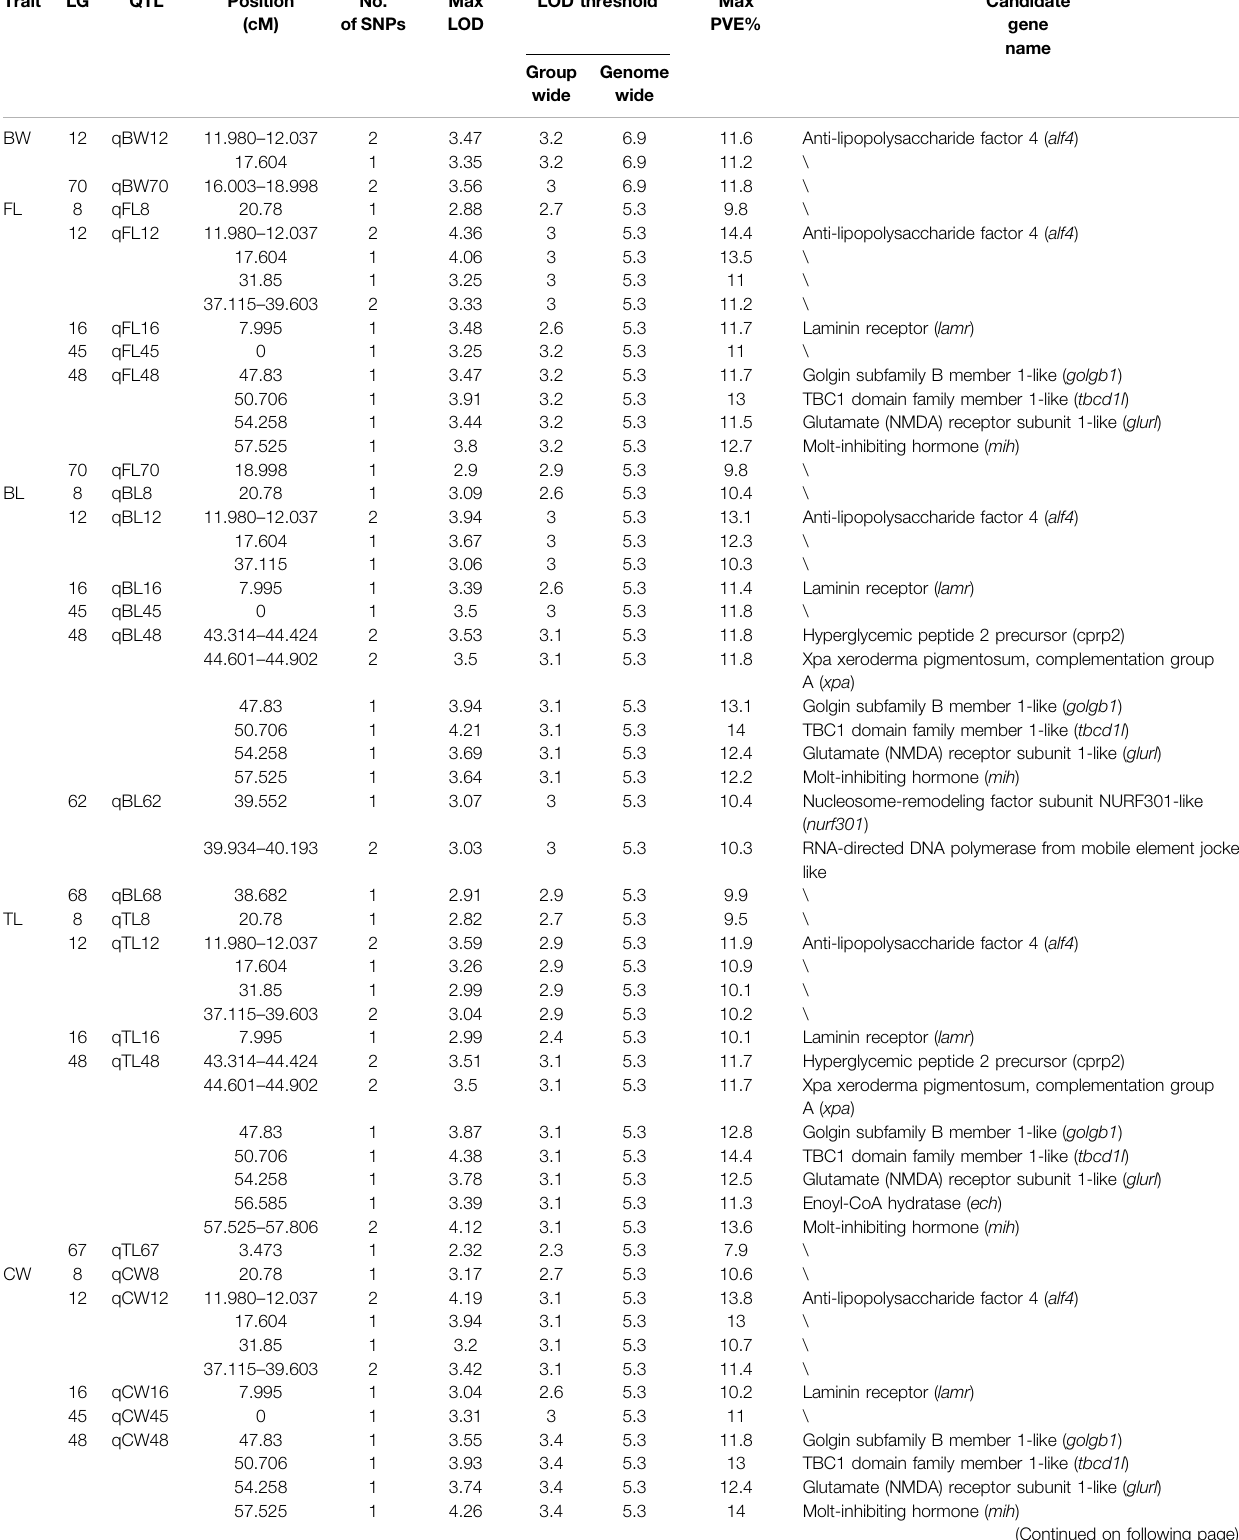
TABLE 3 | Summary information of growth-related QTL and candidate genes. Trait